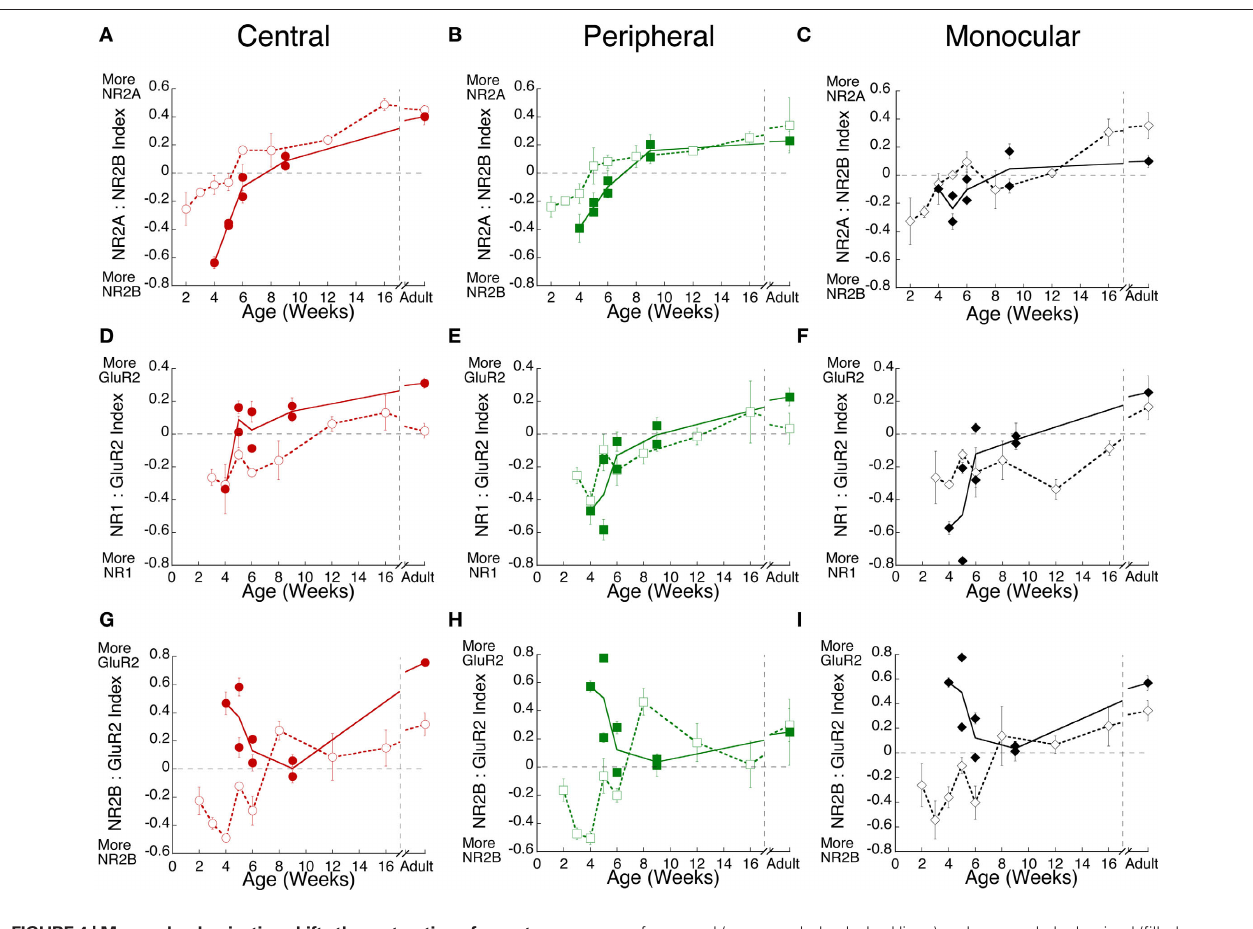
FiGure 4 | Monocular deprivation shifts the maturation of receptor subunit composition. Experience-dependent maturation of the (A–C) NR2A:NR2B, (D–F) NR1:GluR2, and (G–i) NR2B:GluR2 indices was quantified